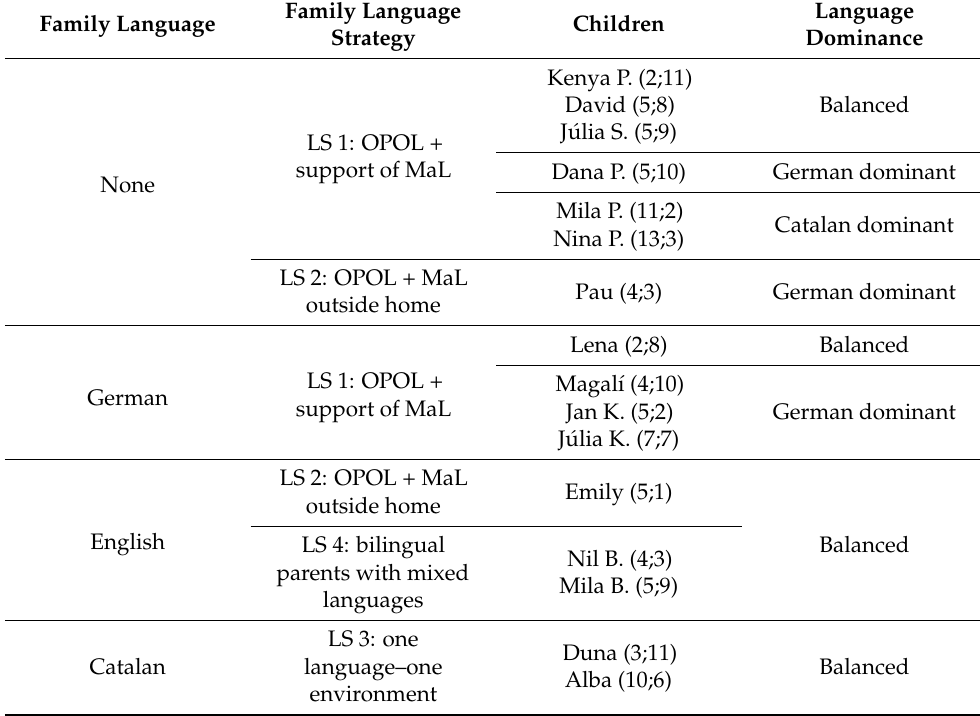
Table 6. Family language across LS and language